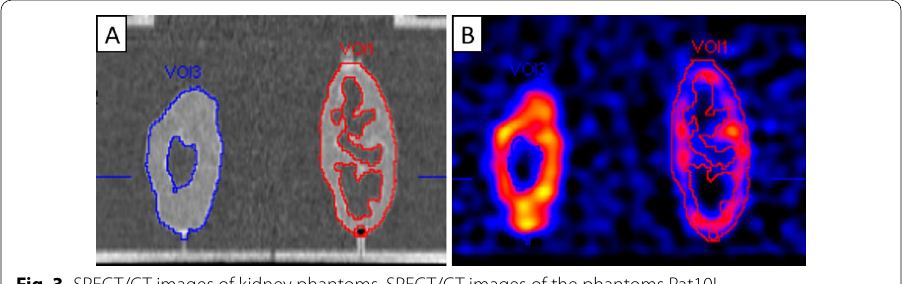
Fig. 3 SPECT/CT images of kidney phantoms. SPECT/CT images of the phantoms Pat10L (whole-parenchyma) and Pat1R (cortex only) acquisitions. The phantoms were filled with a 10:1 target-to-background ratio. The volume of interest (VOI) was defined as the isocontour on the CT image ( A ) in such a way that all voxels inside the phantom were included. The threshold of the isocontour was adjusted so that the volume of the VOI was as close as possible to the actual filling volume of the phantoms. The thresholds for VOI1 and VOI3 were 88%. The VOI was subsequently transferred to the SPECT image ( B )